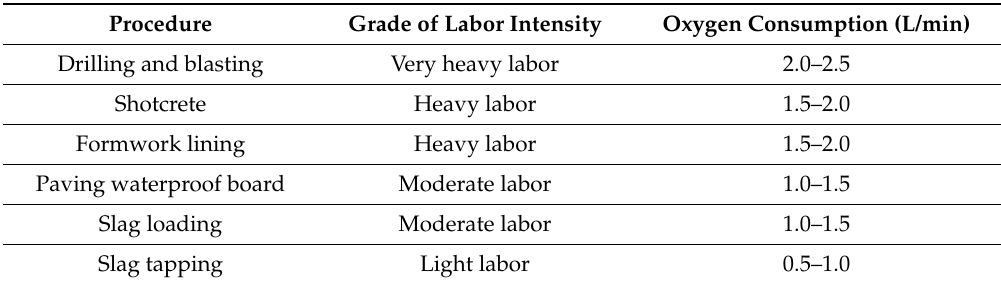
Table 7. Grades of labor intensity of main procedures in tunnel construction and oxygen consumption at sea